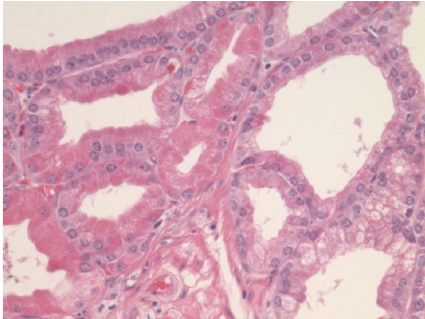
Figure 4: High power view of the PGA showing the ground glass appearance of cytoplasm and a monolayer of round nuclei.